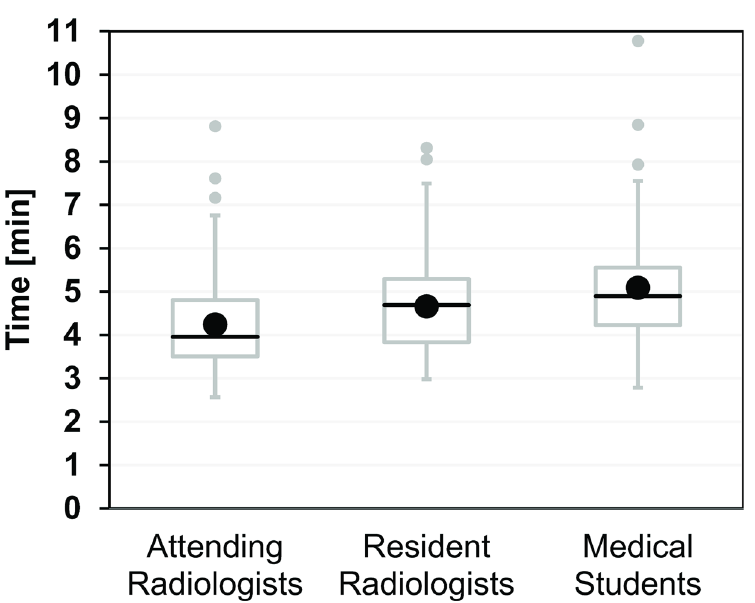
Fig 5. Experimental total biopsy times for 24 operators from three different groups (AR, RR, MS). Each operator performed 10 biopsy cycles in the same order. Each box with whiskers represents the summary of 80 biopsy times from 8 operators. The gray box and black line indicate Q1 – Q3. Whiskers were plotted according to the definition by J. W. Tukey and either indicate the last values a maximum of 1.5 × IQR (interquartile range = Q3 – Q1) away from Q1 and Q3, respectively, or the minimum and maximum, whichever comes first. Each group had 2 – 3 upper outliers (gray circles) with times greater than Q3 + 1.5 × IQR. The black circles indicate the mean biopsy times, which were significantly different between groups (p < 0.01). Post-hoc Bonferroni testing revealed significant differences between AR and RR as well as AR and MS.